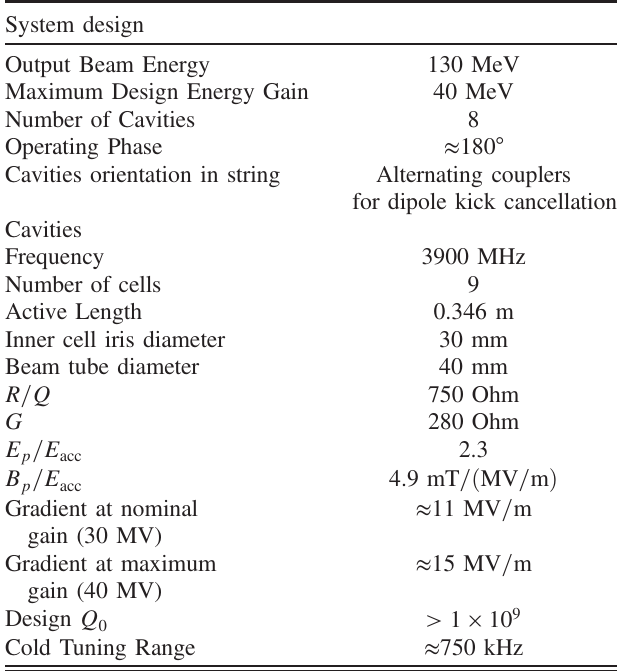
TABLE I. Main system design choices and parameters of the EXFEL third harmonic section